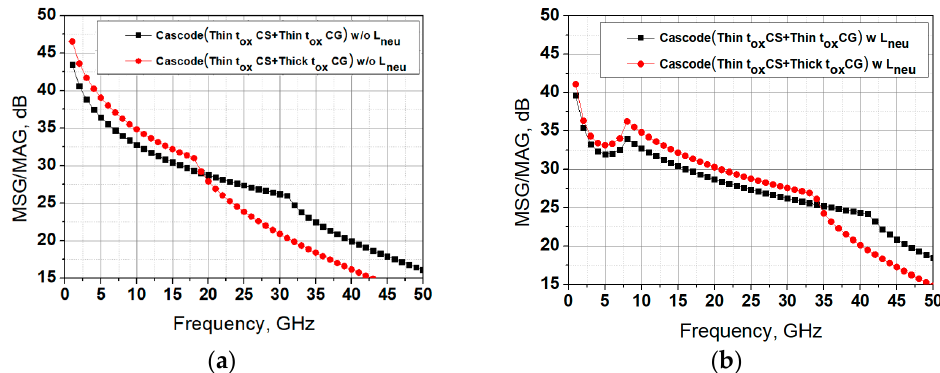
Figure 4. Simulated MSG/MAG of the cascode cells (thin-oxide FET CS + thin/thick-oxide FET CG). ( a ) Without L neutralization. ( b ) With L neutralization at 24 GHz.